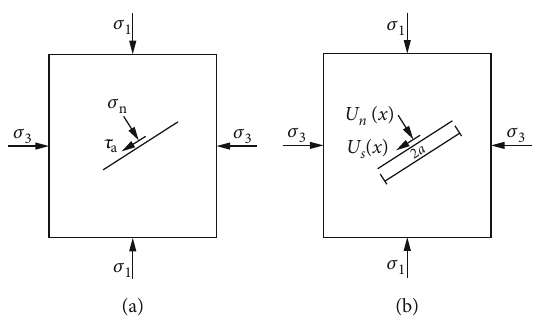
Figure 3: Sketch of mechanical analysis of fracture in the compression-shear state: (a) stress state; (b) deformation